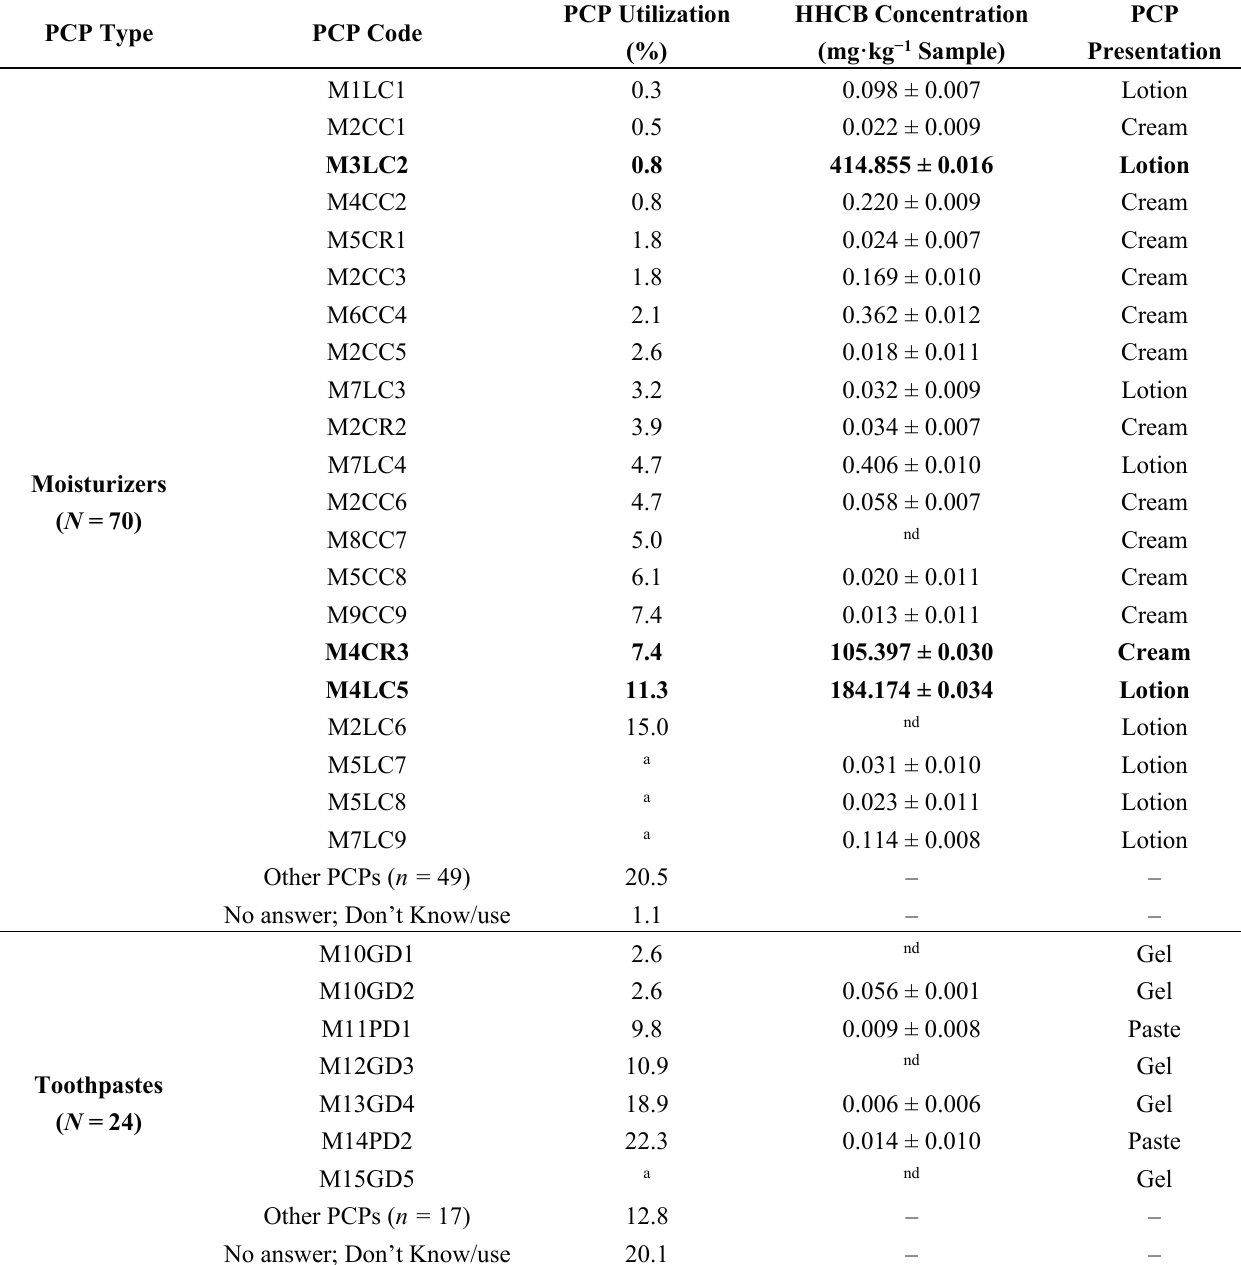
Table 2. Selected personal care products (PCP) based on the level of use (%) obtained in the questionnaires or from hypermarket statistics; respective galaxolide (HHCB) concentrations (highest concentrations in bold) and PCP